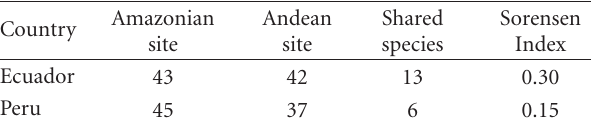
Table 2: Number of forest bird species observed in Amazonian and Andean sites in Ecuador and Peru, and Sorensen Similarity Index. Amazonian Andean Shared Sorensen Country site site species Index Ecuador 43 42 13 0.30 Peru 45 37 6 0.15